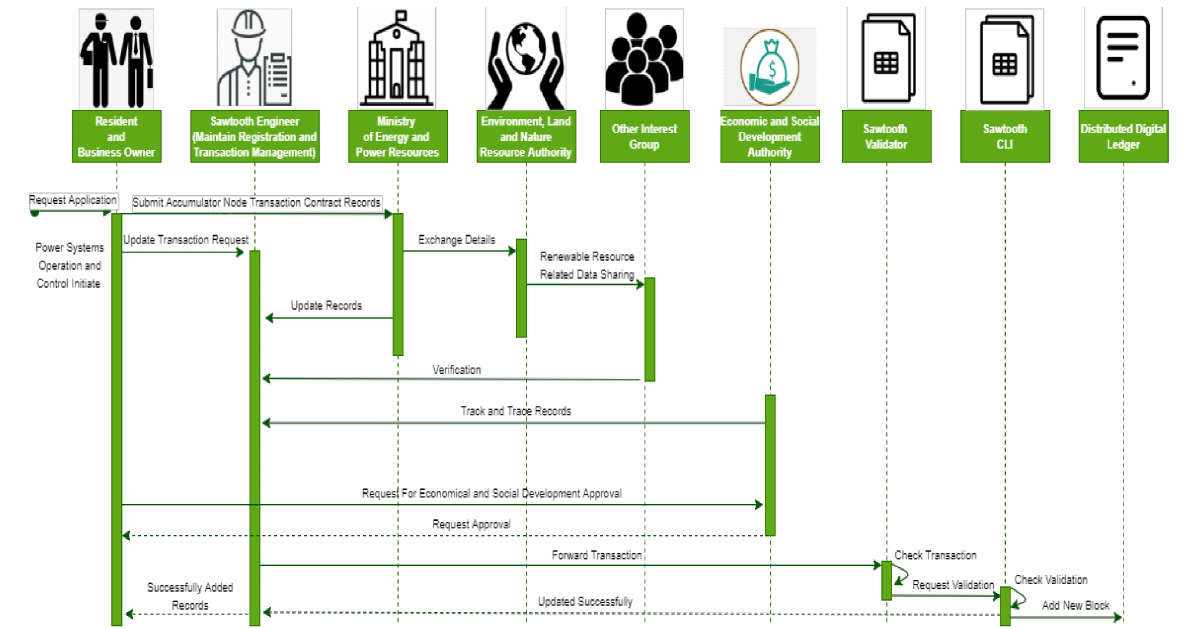
Figure 14. The working of blockchain Hyperledger Sawtooth-enabled EPS-ledger registration, validation, and verification process through sequence